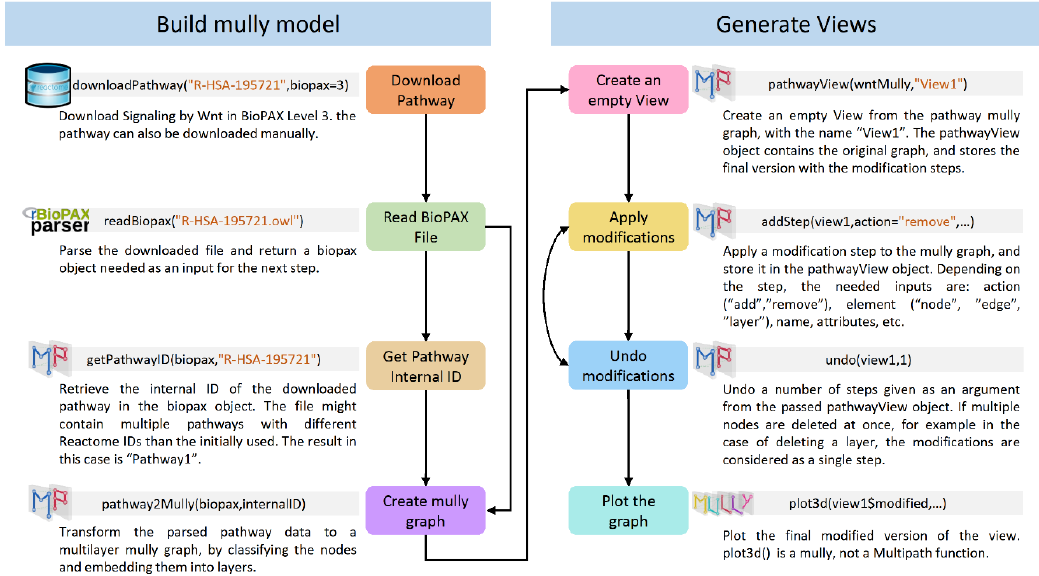
Figure 1. Reproducibility Workflow Diagram. The diagram shows the steps that have to be followed to generate reproducible multilayer pathway models. The Signaling by Wnt pathway was used as an